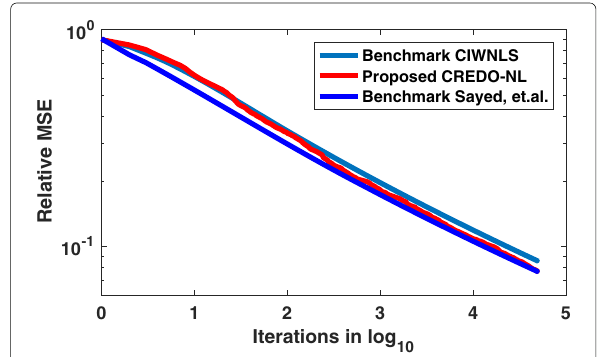
Fig. 2 Comparison of the proposed and benchmark estimators in terms of relative MSE: Number of Iterations. The light blue line represents the CIWNLS algorithm, the dark blue line represents the diffusion based algorithm proposed in [43], and the red line represents the proposed